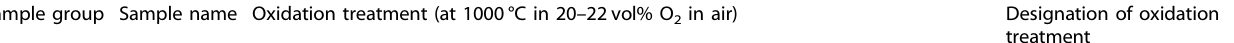
Table 3. Description of types of oxidation thermal treatments of L-DED fabricated IN718 and designation of corresponding sample